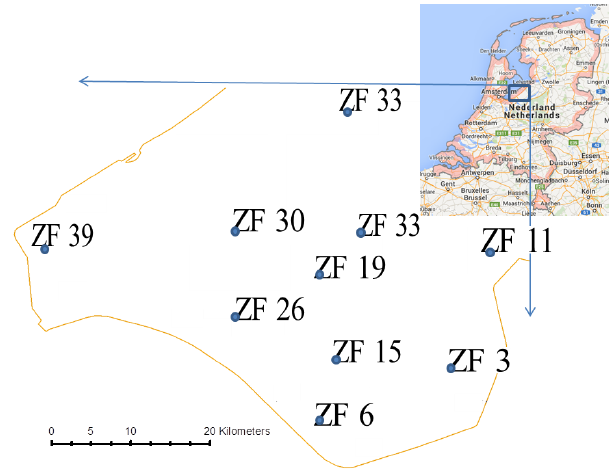
Figure 1. Map of the SE Flevopolder with the selected locations.